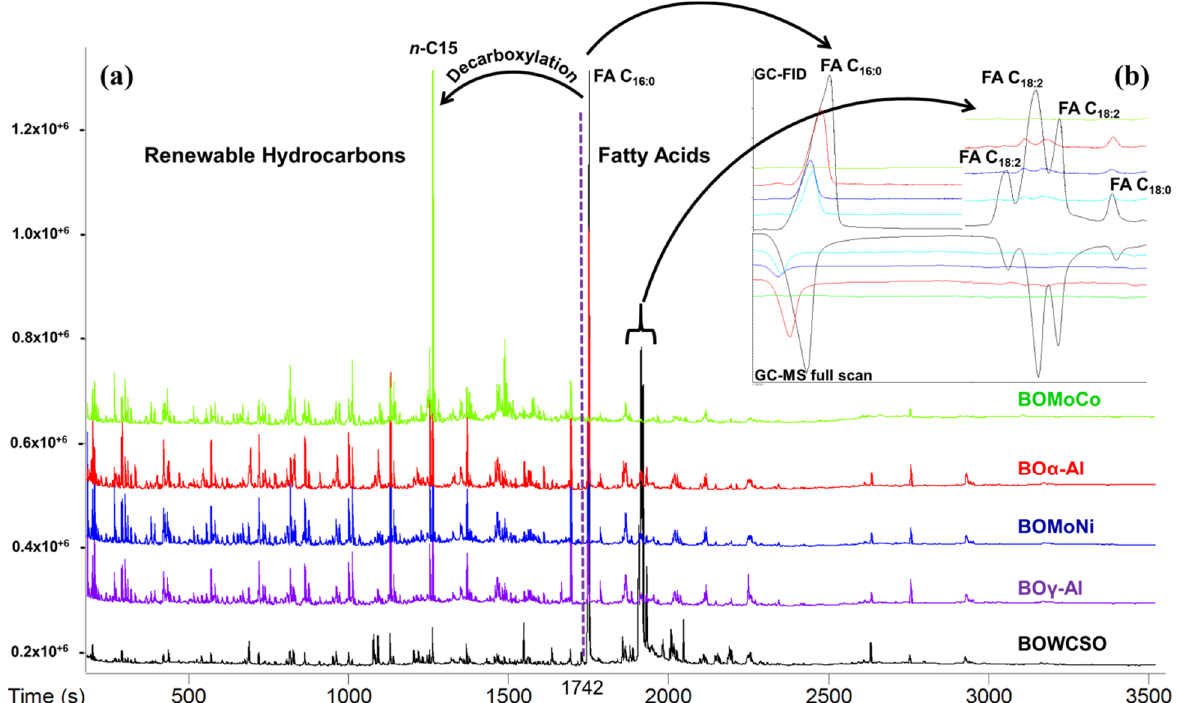
Figure 6. ( a ) Chromatograms of the non-catalytic and catalytic bio-oils obtained by GC-FID and used in the quantification of renewable hydrocarbons and ( b ) FID vs. MS comparison in the range of the retention times for palmitic acid (FA C 16:0 ); linoleic acid (and isomers, FA C 18:2 ), and stearic acid (FA C 18:0 ).